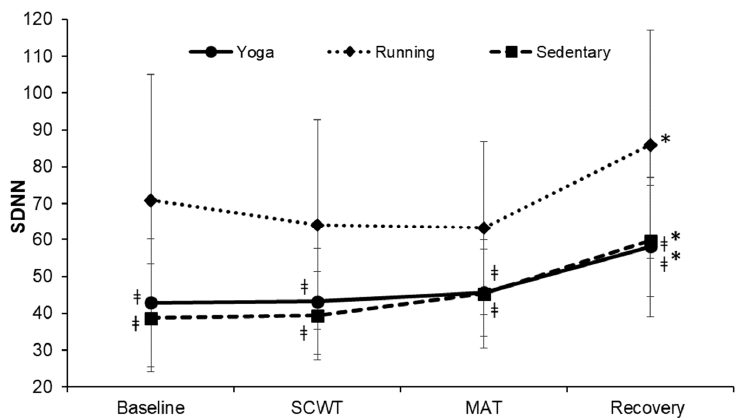
Figure 5. Changes in the total power over time. SCWT, The Stroop color and word test; MAT, The mental arithmetic task. ‡ significantly different from running group, p < 0.05. * significant difference between baseline and each phase within a group, p < 0.05.